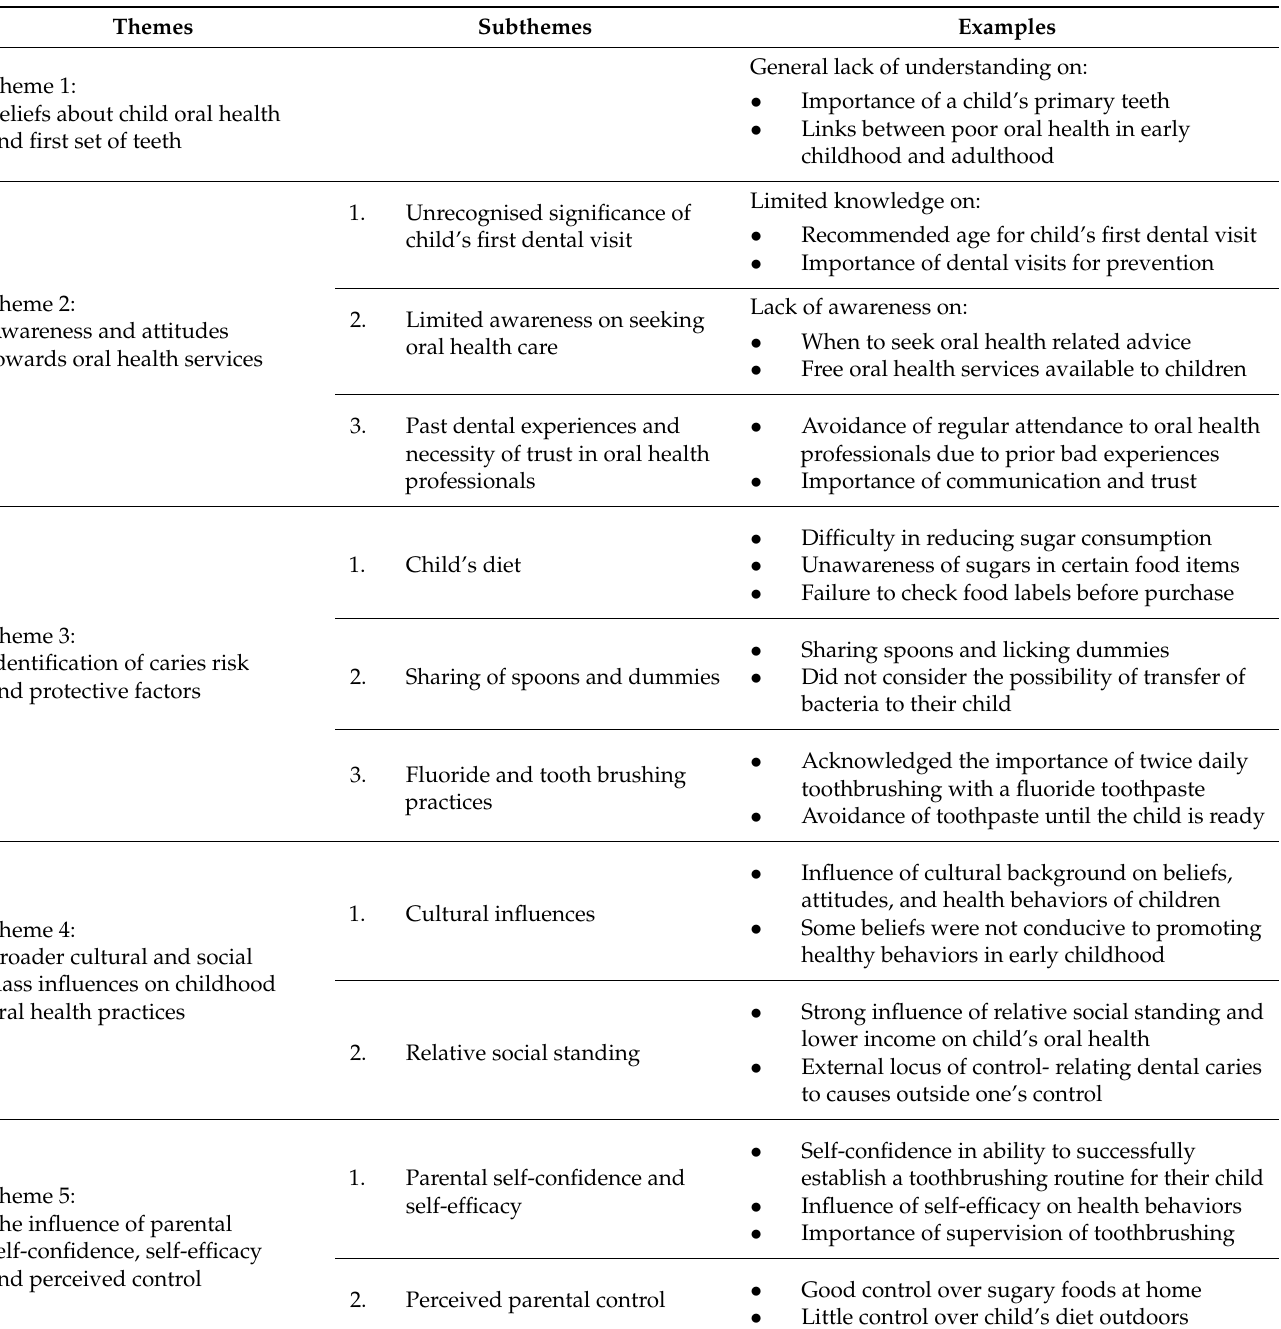
Table 3. Summary of themes, subthemes, and